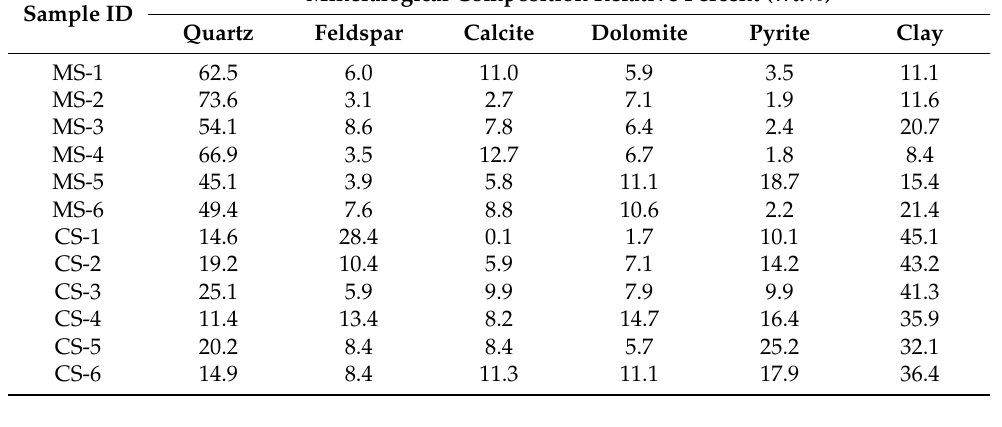
Figure 2. Mineral composition and TOC content distribution of marine shale (MS) and continental shale (CS).